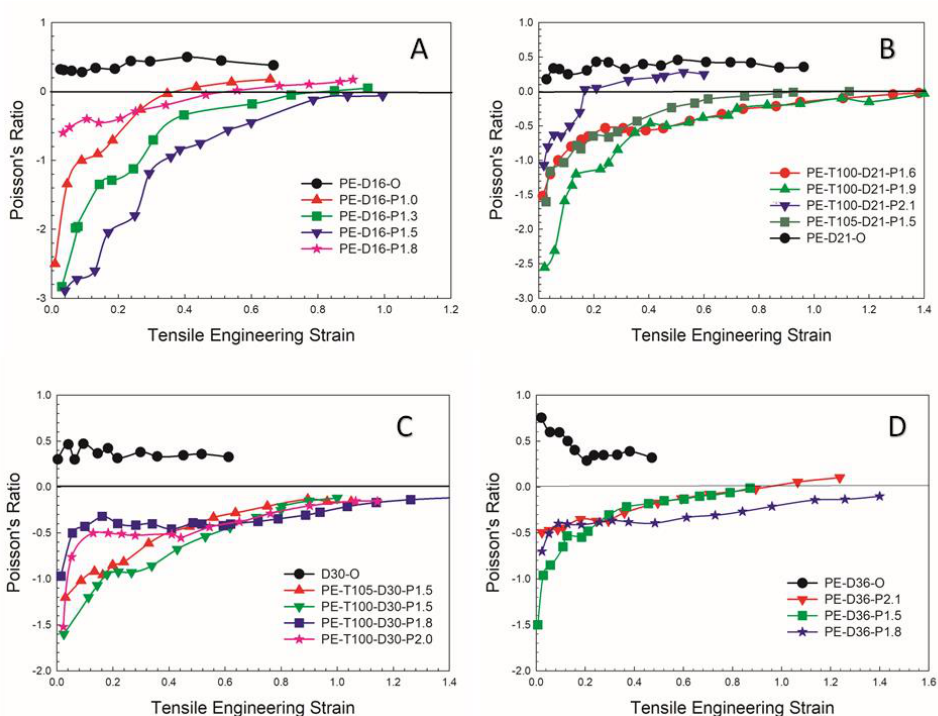
Figure 5. Poisson’s ratio as a function of tensile engineering strain for auxetic foams produced under different conditions (temperature and mechanical compression) with their initial foams based on